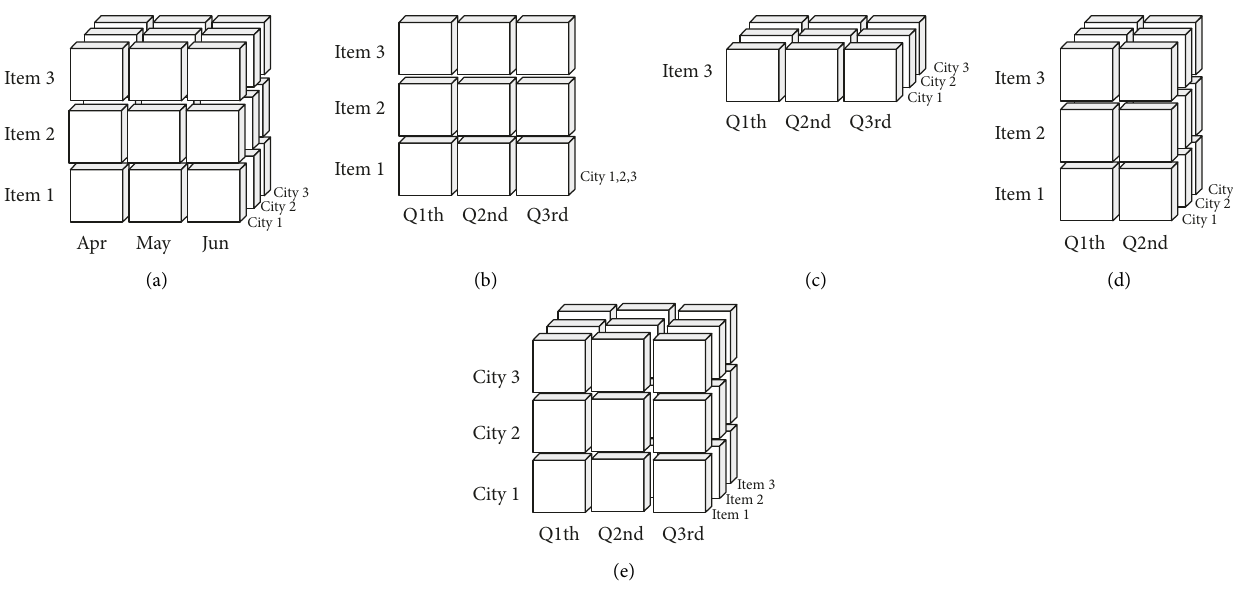
Figure 12: Time-sharing behavior heat diagram of users.